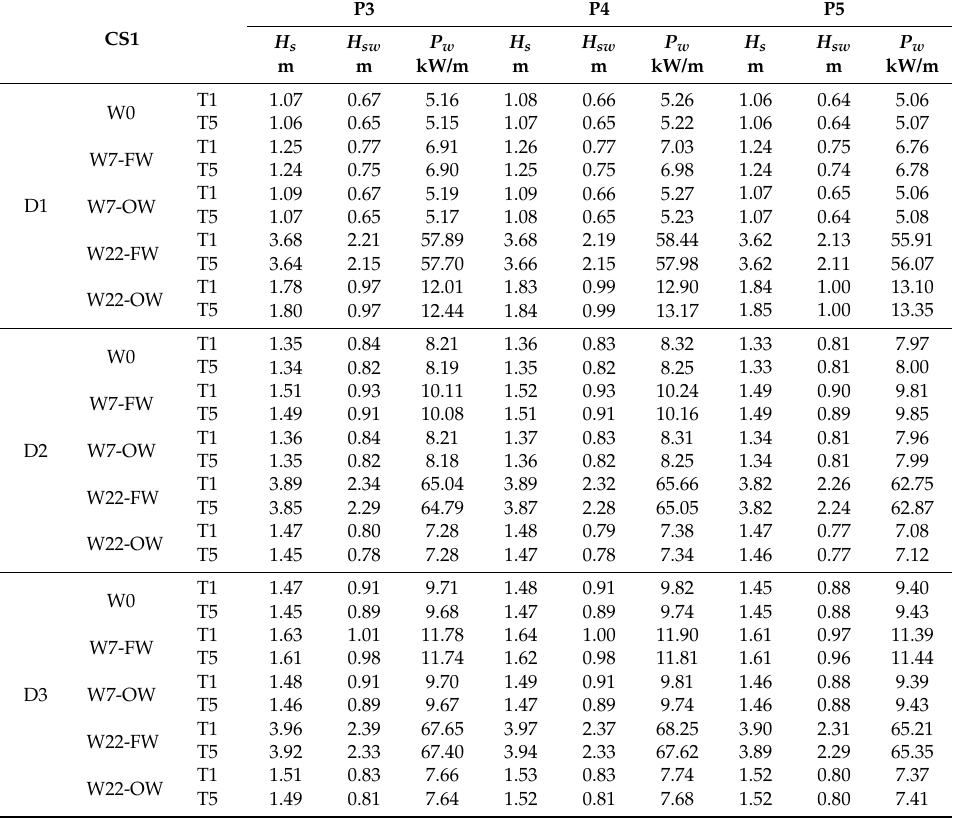
Table 4. SWAN results for CS1, corresponding to the reference points P3, P4, and P5, the tide levels T1 and T5, and the wind conditions W0, W7, and W22, in terms of the wave parameters H s , H sw , and P w .